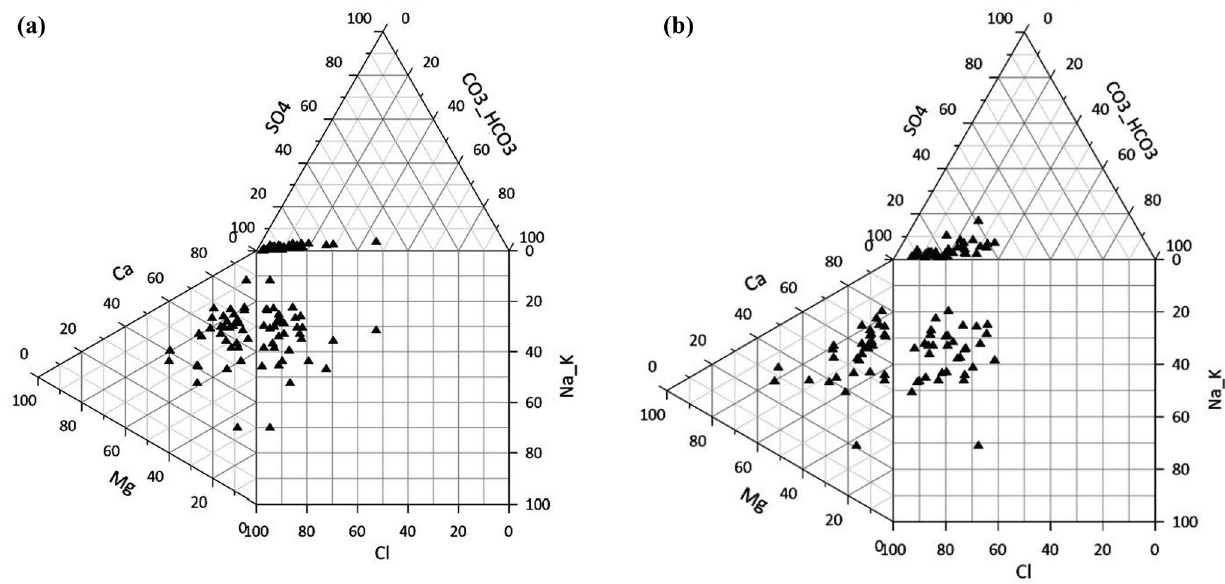
Fig. 5 Durov’s diagram showing types of water and stages of groundwater evolution of the study area during ( a ) PM and ( b ) PoM